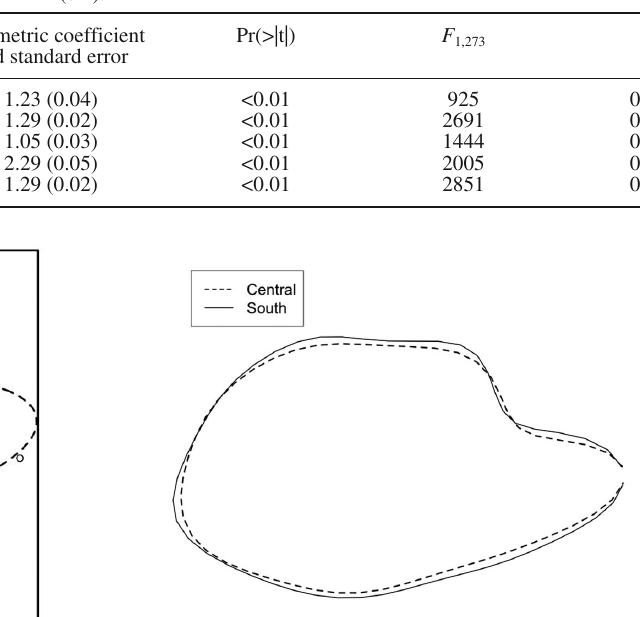
Fig. 7. – Average outline from the average elliptical Fourier coef- ficients of each locality.